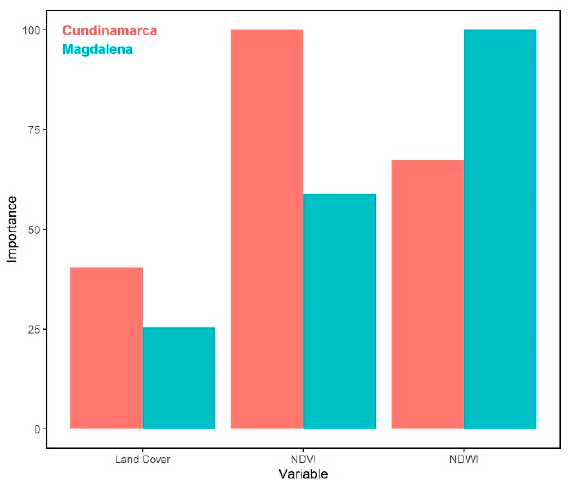
Figure 8. Degree importance for each feature in the X-matrix of the Naïve-Bayes classification. Red bars represent Cundinamarca , and the blue bars represent Magdalena .